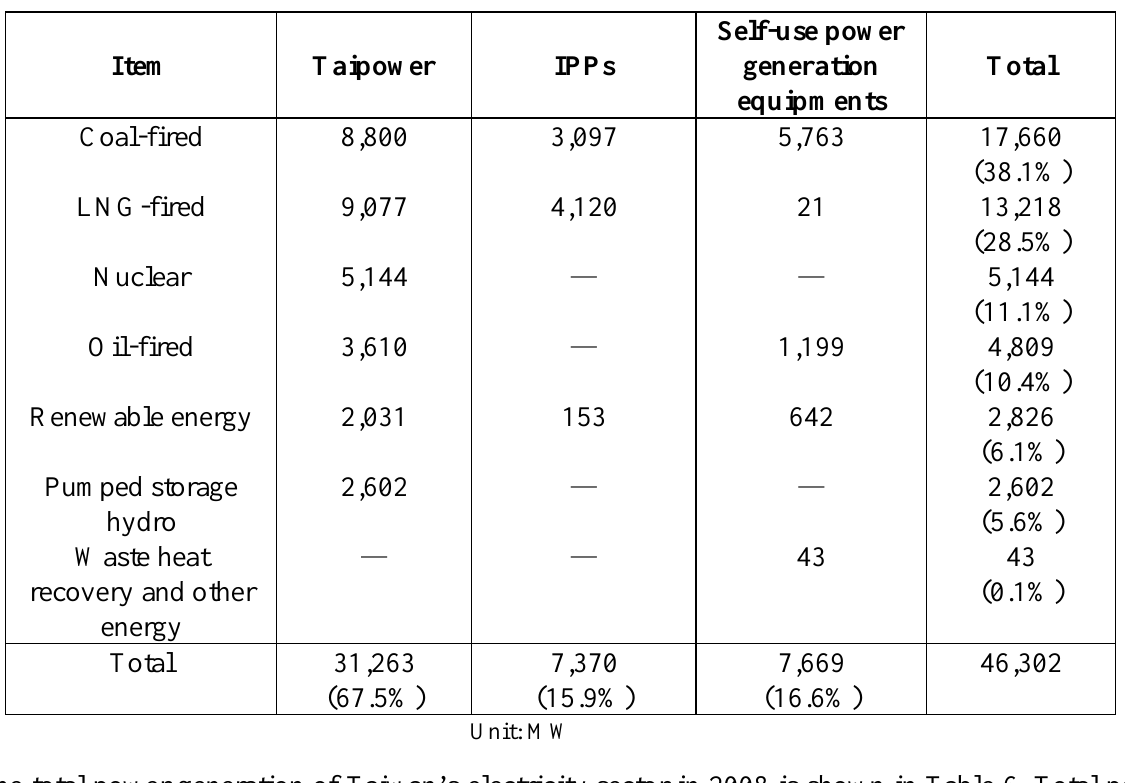
Table 5. Total installed capacity in Taiwan in 2008